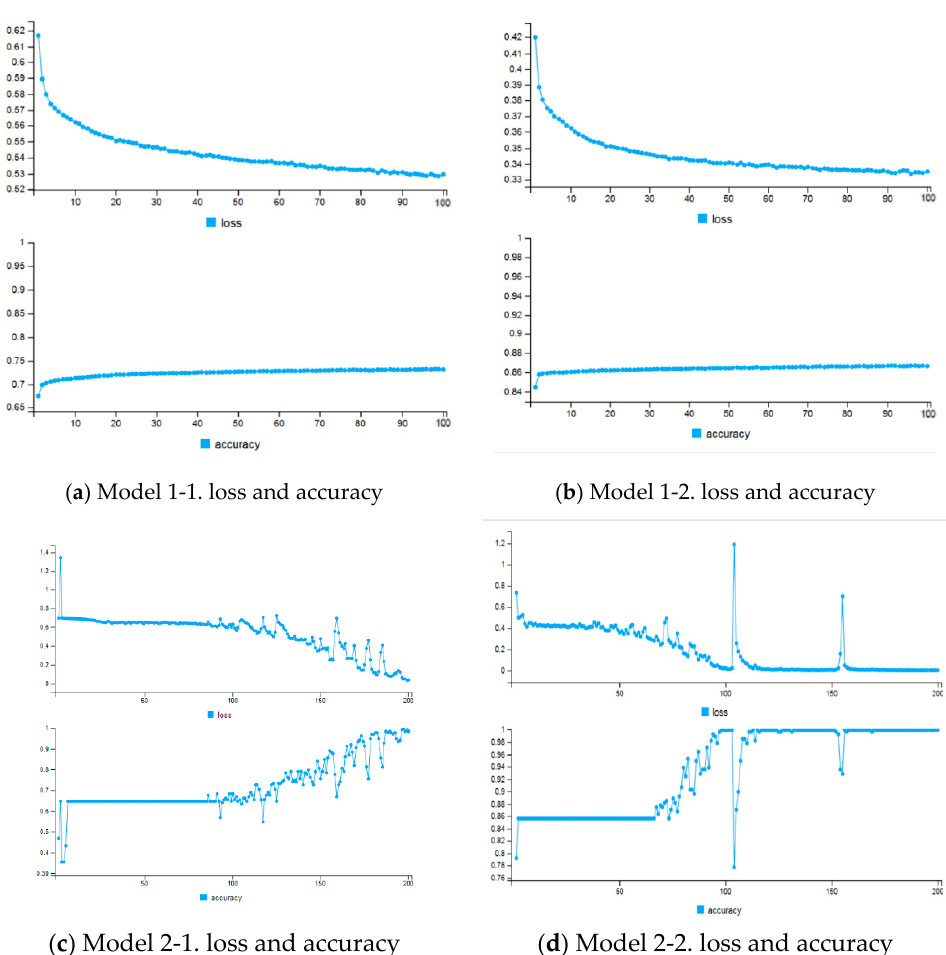
Figure 4. Losses and Accuracies of the Four Models. We divided the students in BMI 4 into two parts, one with BMI% < 97th percentile, and the other with BMI% ≥ 97th percentile. No student had an exact BMI % of the 97th percentile. A total of 17 students among 25 students in BMI 4 were over a BMI % of the 97th percentile. Among the 17 students with a BMI% > 97th percentile, 10 students were used to train the feedforward and convolutional neural networks, and 7 students were used for testing the neural networks. The students with a BMI % < 97th percentile, as well as those in BMI 1, 2, and 3, were merged and labeled "0". The students with a BMI % ≥ 97th percentile was labeled “1”. The feedforward and convolutional neural networks were trained with the new dataset coded in “0” and “1”. The feedforward and convolutional neural networks with the new dataset show the highest rate of accuracy among all the tested models. The accuracy of feedforward neural networks using the new dataset is 92.6%, as displayed in Figure 5a. As is shown in Figure 5b, the accuracy of convolutional neural networks using the new dataset is